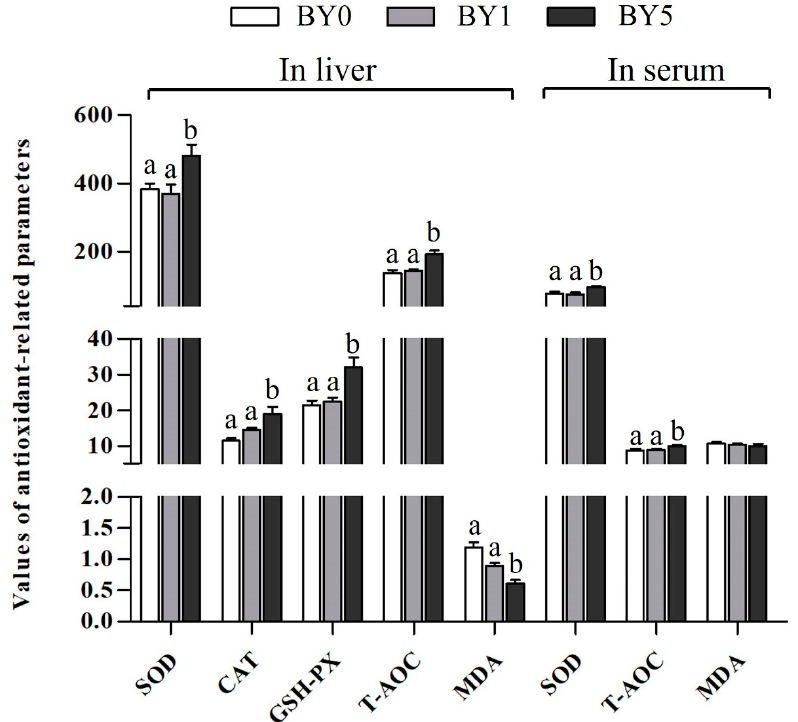
Figure 3. Antioxidant-related parameters in liver and serum of T. ovatus fed experimental diets. Values are presented as mean ± SE ( n = 18). The small letters indicate significant differences at p < 0.05. SOD, superoxide dismutase (U mg protein − 1 in liver; U mL − 1 in serum); CAT, catalase (U mg protein − 1 ); GSH-PX, glutathione peroxidase (U mg protein − 1 ); T-AOC, total antioxidant capacity (mmol g protein − 1 in liver; mmol L − 1 in serum); MDA, malondialdehyde (nmol mg protein − 1 in liver; nmol mL − 1 in serum).